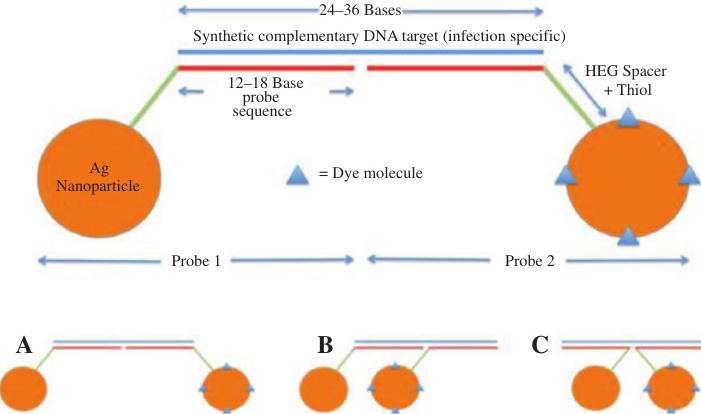
Figure 3: The top scheme shows the hybridization of nanoparticle probes to complementary single stranded DNA. The length of the probe sequence can be varied to increase discrimination and stability. The Raman reporter (dye) is added to the nanoparticle surface along with the DNA probe sequence to create a unique code for this particular DNA sequence. Schematics (A–C) represent the three different orientations that the probes can take when attaching to a complementary single strand of DNA due to the stereochemistry induced by the deoxyribose sugar on DNA. (A) Tail-to-tail, (B) head-to-tail, (C) head-to-head. Adapted with permission from [156]. Copyright 2015 American Chemical